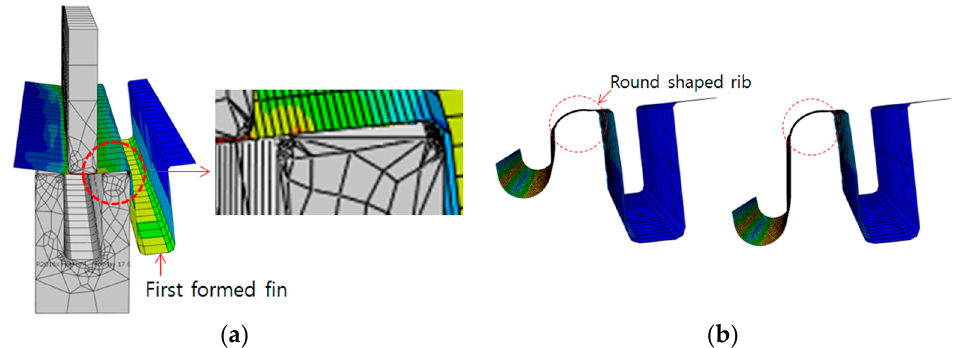
Figure 9. Simulation results for second fin forming by stamping process: ( a ) blank compressed by punch and ( b ) rib deformation to a round shape.